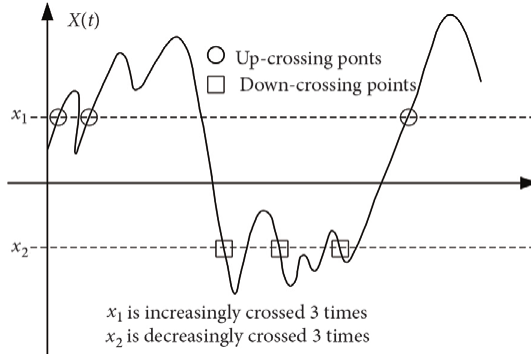
Fig. 9. Sample function of continuous stochastic